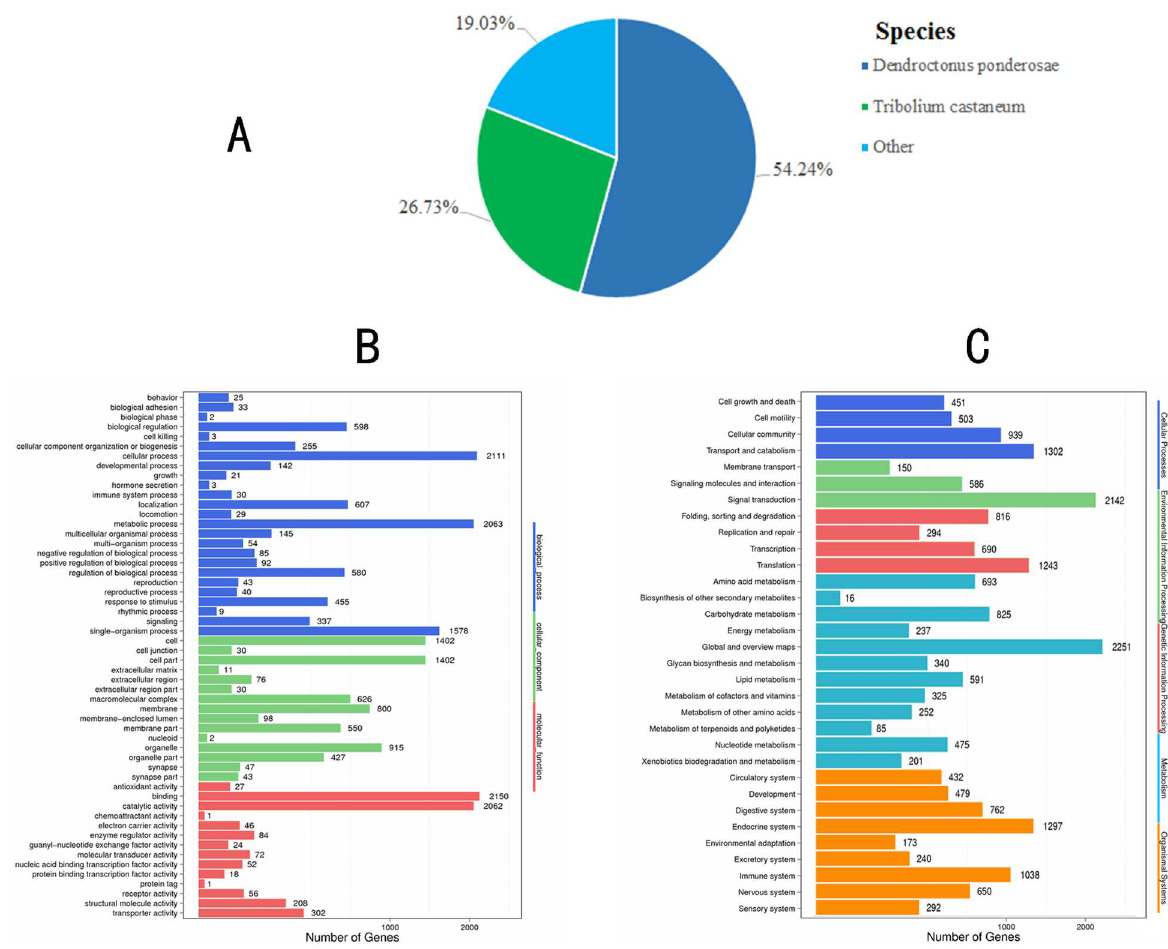
Fig 2. The functional annotation of assembled unigenes of S . zeamais in different databases. (A) Speciesdistribution of unigenes with the best hit annotation terms in the Nr database; (B) GO classifications of assembled unigenes;(C) KEGG classifications of